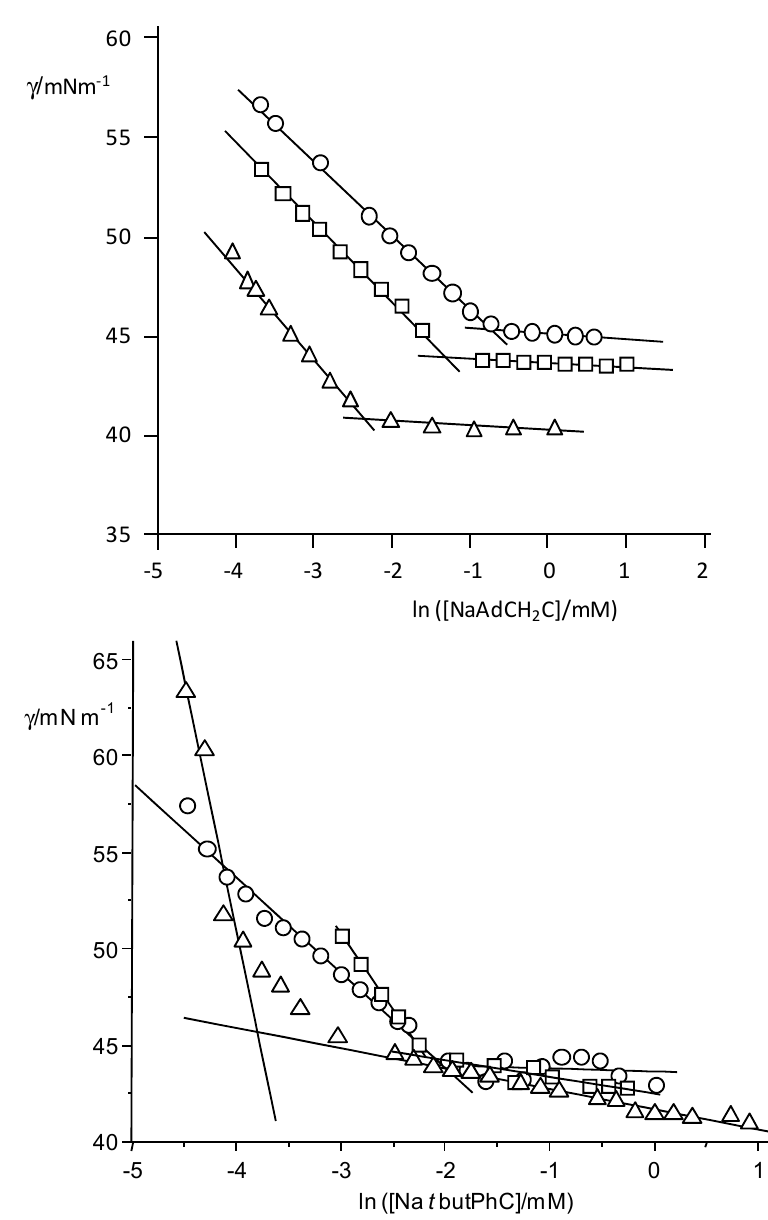
Figure 2. Plots of γ (mNm − 1 ) vs. ln([surfactant]/mM) in carbonate/bicarbonate buffer with the indicated total concentrations; T = 25 °C. NaAdC (top): 0.050 (circles), 0.150 (squares), and 0.70 M (triangles). NaAdCH 2 C (middle): 0.0506 (circles), 0.150 (squares) and 0.70 M (triangles)Na t butPhC (bottom): 0.050 (circles), 0.150 (squares), and 1.00 M (triangles). The cmc’s of the three anionic surfactants are influenced by the counter ion concentration in the aqueous medium. From this dependence, the degree of counterion binding ( β ) in micelles (Corrin–Harkins plot) may be obtained [30,31]. It may be written as log 𝑐𝑚𝑐 = 𝐴 − 𝛽log [𝑁𝑎 (cid:2878) ] (1) The β values obtained from the slopes of the straight lines in Figure 3 are 0.49 (NaAdC), 0.63 (NaAdCH 2 C), and 0.65 (Na t butPhC), which are within the range (0.26–0.66) of published values for sodium alkanoates [32–34].